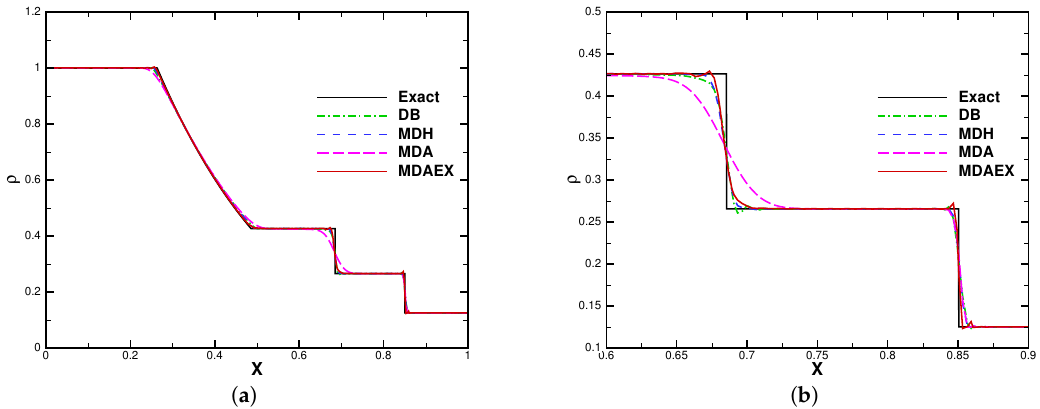
Figure 5. Density solution for the Sod problem with 100 elements at t = 0.2, P 3. ( a ) Overview; ( b ) zoomed in